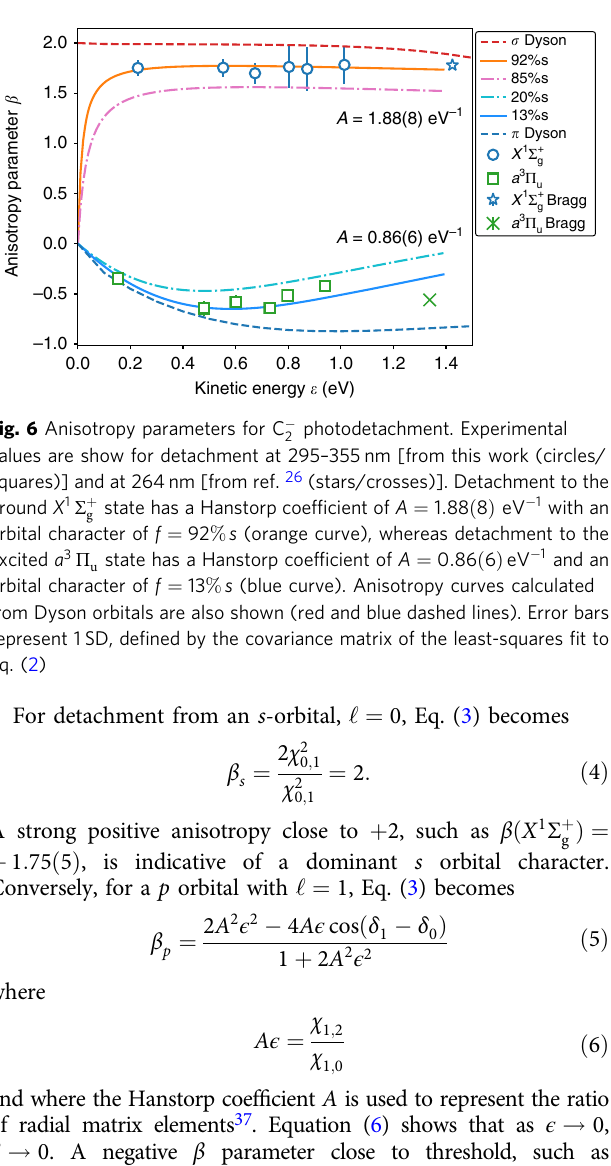
β ( a 3 Π ) ¼ (cid:1) 0 : 35 ð 1 Þ . u